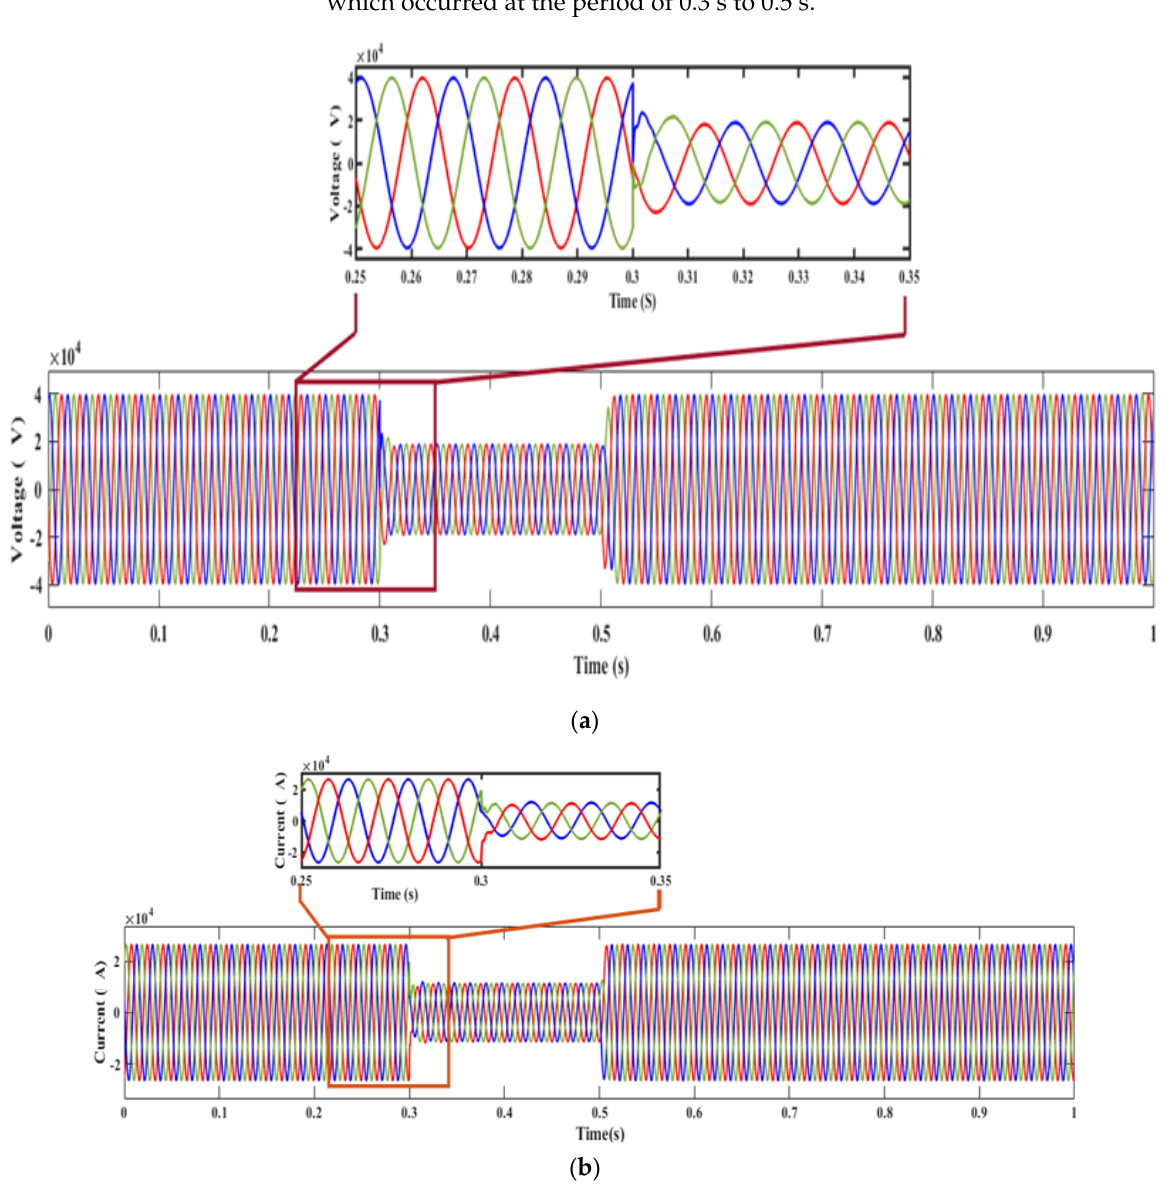
Figure 6. Analysis of ( a ) Bus 2 voltage and ( b ) Bus 2 current under power swing conditions.